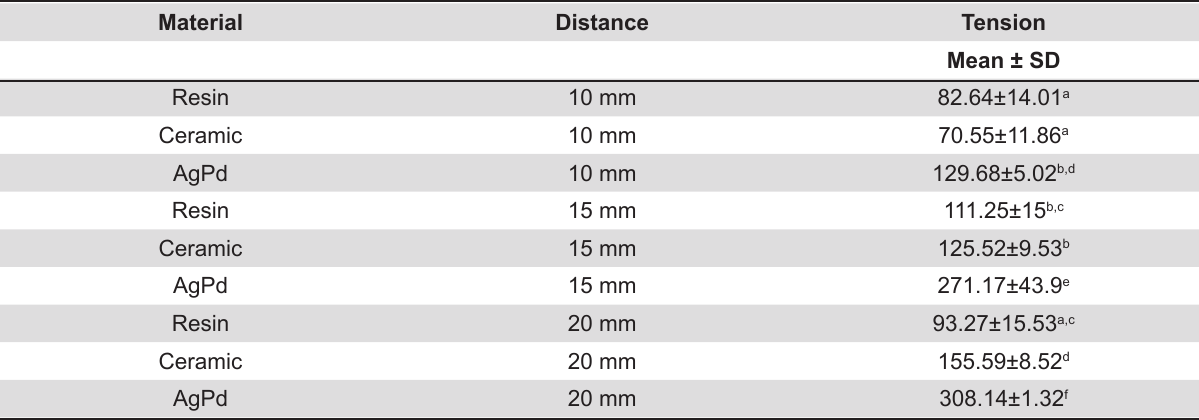
Table 2- Mean values (MV) and standard deviation (SD) for tension deformation ( me ) for the different groups at different points of the force